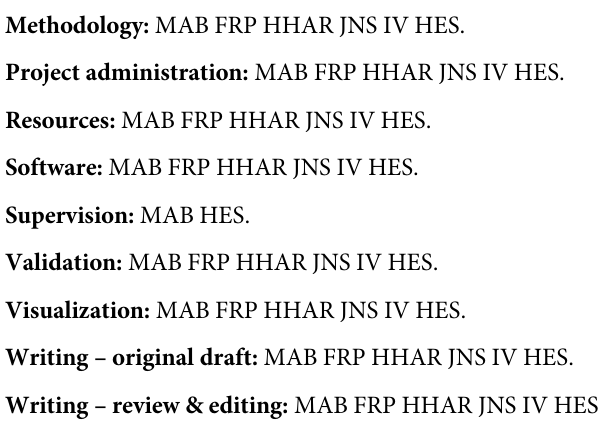
S1 Appendix. A1 Table, Values attributed to general parameters. A2 Table, Descriptive Statis- tics (Agents 100% Fundamentalists). A1 Fig, Evolution of the Stock Rate of Return (Agents 100% Fundamentalists). A2 Fig, Shapiro -Wilk Normality Test Stock Rate of Return (Agents 100%